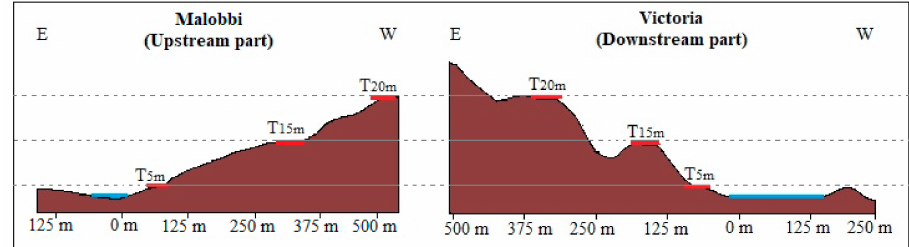
Figure 12. Cross-sectional topographic profiles of Malobbi (Upstream part) and Victoria (Downstream part) with correlated terrace